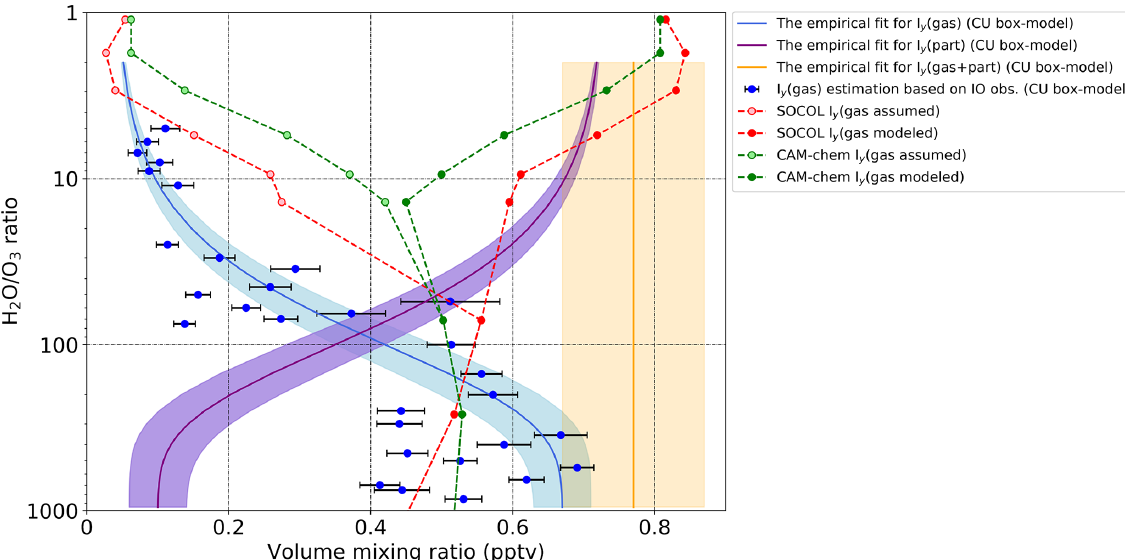
Figure 5. Total gas-phase I y modeled with SOCOL-AERv2-I and CAM-chem as well as estimated by CU chemical box model based on AMAX-DOAS IO observations in the upper troposphere and lowermost stratosphere. All model data and observations are taken only for the region of TORERO (10 ◦ N–40 ◦ S, 250–285 ◦ E) and CONTRAST measurements (40 ◦ N–15 ◦ S, 115–175 ◦ E). Red and green solid and dashed lines: gas-phase I y simulated with SOCOL-AERv2-I and CAM-chem averaged for the January–February period. Light red and light green dashed lines: assumed gas-phase I y simulated with SOCOL-AERv2-I and CAM-chem excluding approx. iodine in the particulate phase. Blue dots: gas-phase I y modeled by the University of Colorado (CU) chemical box model. Black error bars: the uncertainty in I y modeled by the CU box model. Blue, purple, and orange solid lines represent the empirical fit for gas-phase I y (gas), particulate I y (part), and total I y (gas + part), correspondingly. Shadings represent the uncertainty in the empirical